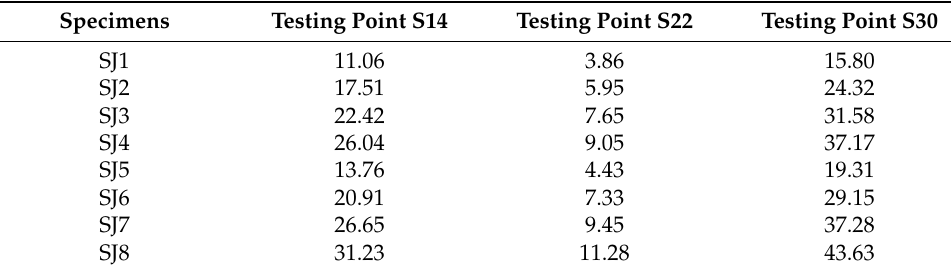
Table 2. Cold-bending stress results (MPa).